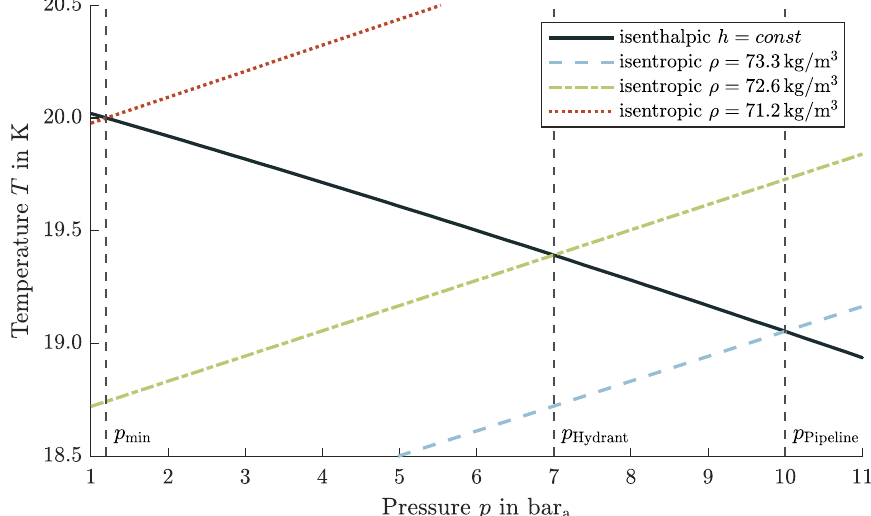
Figure 4. Effects of temperature and density of a real compressible fluid on pressure losses due to friction; showing an isenthalpic change of state from the storage tank pump to the aircraft